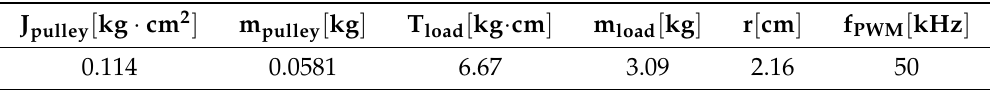
Table 2. Key parameters of the experimantal